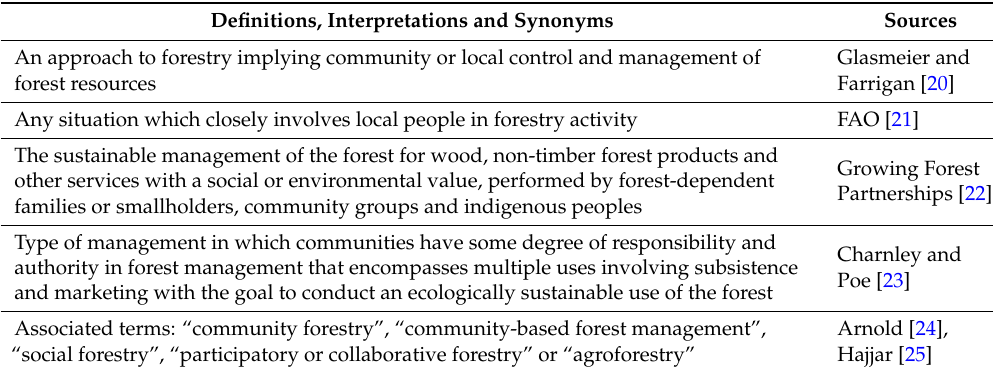
Table 1. Concepts of community forest